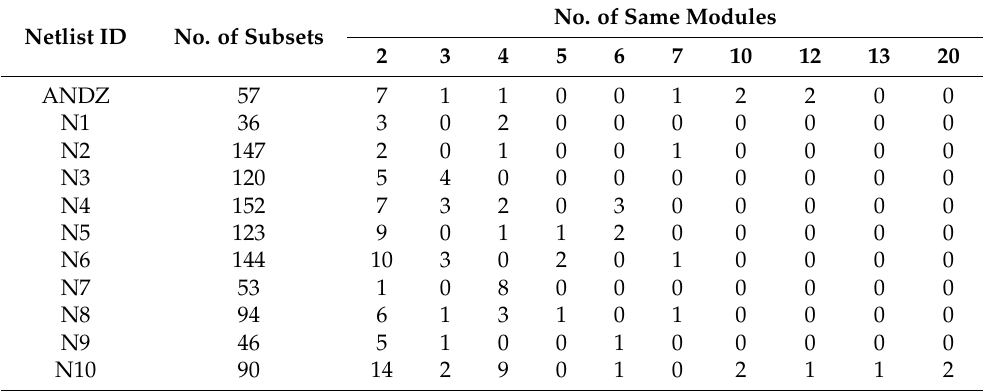
Table 1. The statistics of the number of subsets and repetitive modules in each netlist